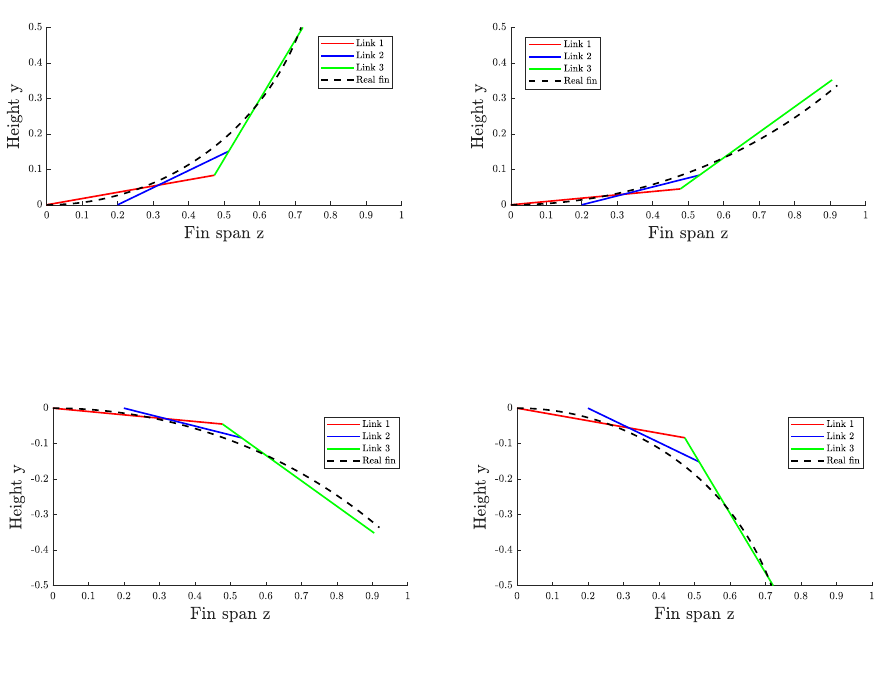
Figure 5. Comparison between the curves of deformation of a real cownose ray and the shape obtained by the links in the mechanism of the central